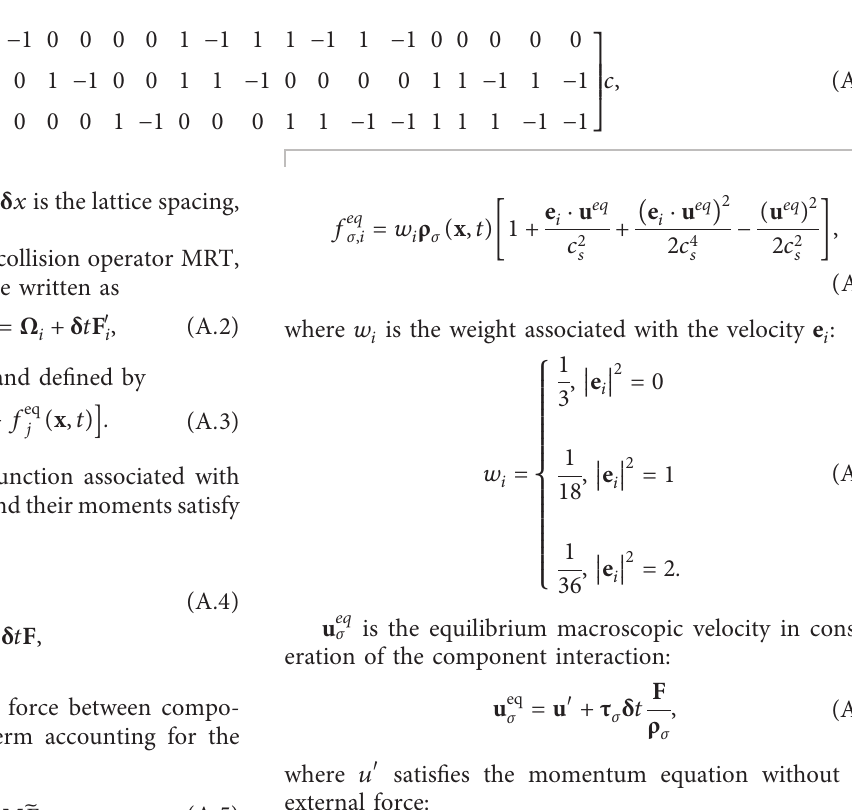
Figure 11: The structure of the D3Q19 lattice with lattice